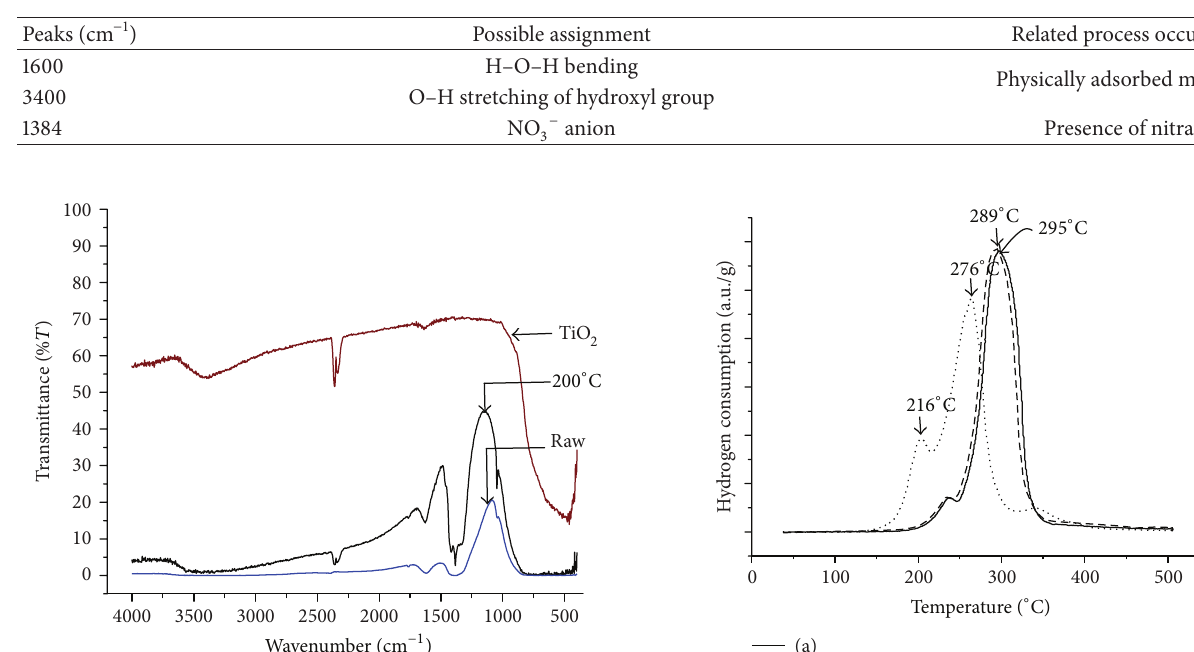
Table 1: Assignment of absorption peaks observed in FTIR spectra of bare TiO